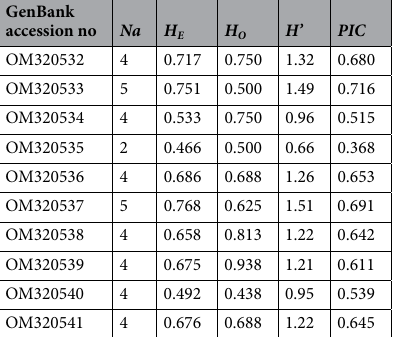
Table 2. Genetic diversity of ten microsatellites in five duplex PCR reactions of sterlet. The table includes number of alleles observed ( Na ), observed heterozygosity ( H O ), expected heterozygosity ( H E ), Shannon– Wiener diversity indices ( H ′ ), polymorphic information content ( PIC ).